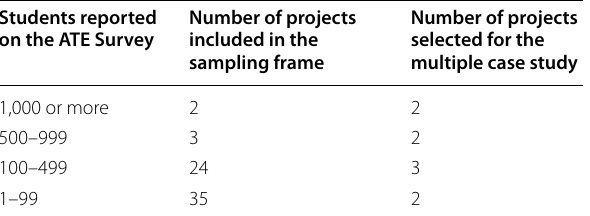
Table 1 Grouping categories (based on the total duplicated count of students) Students reported Number of projects on the ATE Survey included in the sampling frame